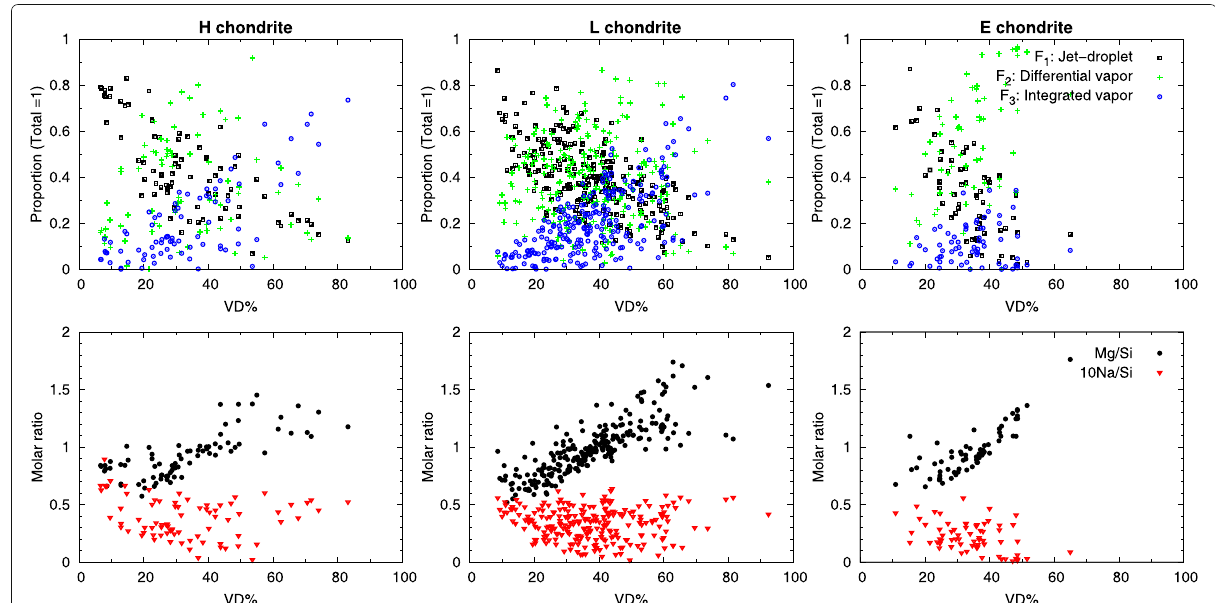
Fig. 13 Upper panels: Calculated proportions of the three components that constitute chondrules as a function of calculated VD%. Lower panels: Element/Si molar ratio in the chondrules as a function of calculated